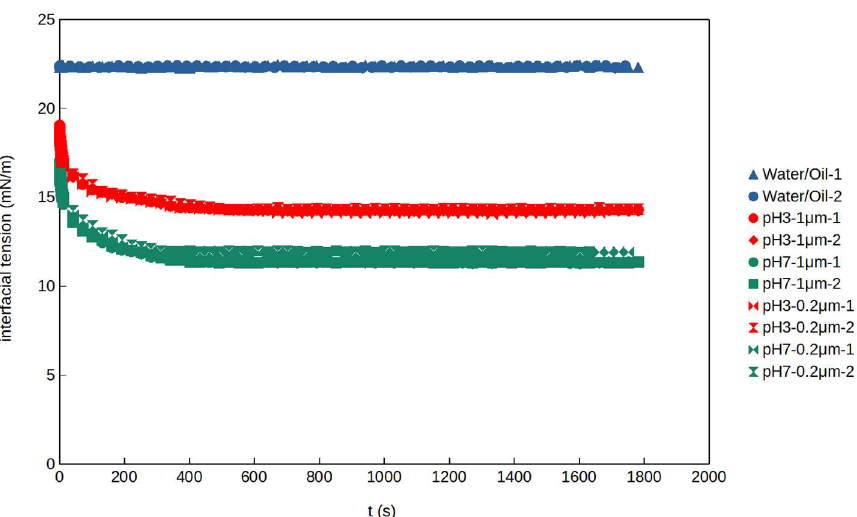
Figure 6. Dynamic oil–water interfacial tensions induced by adsorbed BE at 1% w/w , different pH, and filtered by different pore size filters (1 μm and 0.2 μm) after dissolution. 1, 2 denote two repetitions of the measurements.